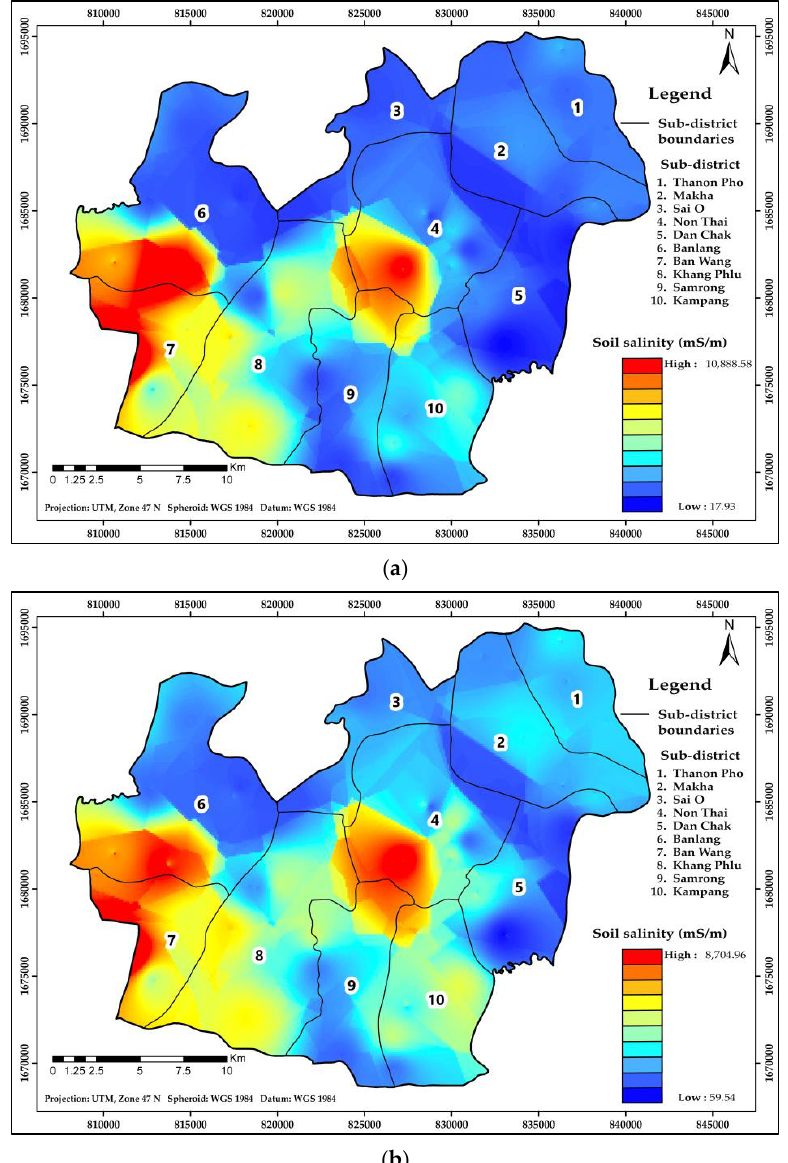
Figure 9. Spatial distribution of soil salinity prediction using IDW of two modes: ( a ) HH and ( b ) VV.